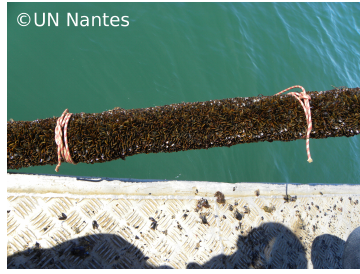
Figure 2. Colonisation of uni-layered mussels on the mooring rope of a mussel